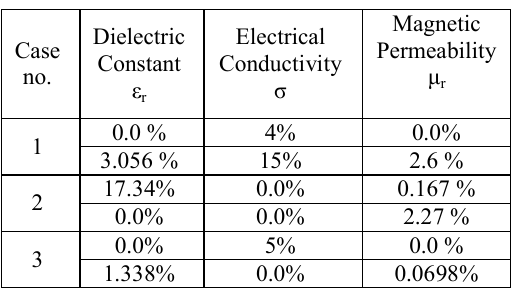
Table 5: Relative percentage error δ (%) of estimated Physical Properties of each layer of the three case studies after the inversion